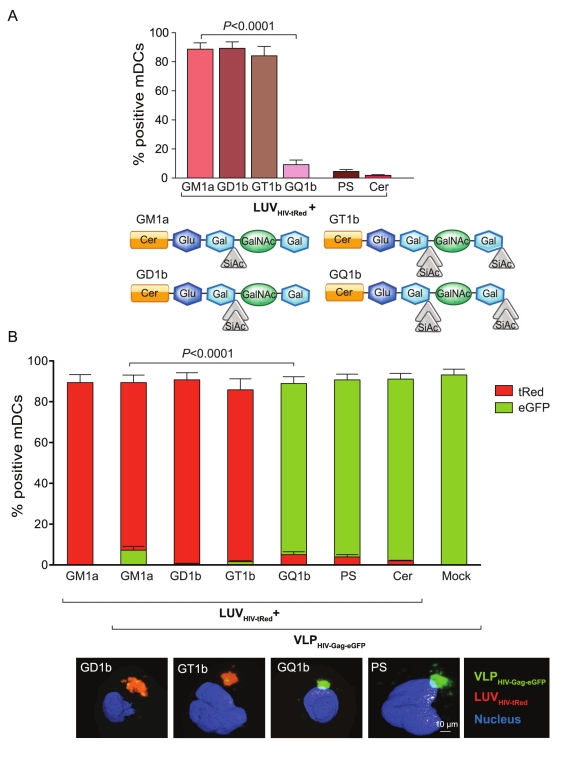
Ganglioside complexity determines mDC capture.(A) Comparative mDC capture of distinct LUVHIV-tRed containing GM1a, polysialogangliosides such as GD1b, GT1b, and GQ1b; PS and Cer. A total of 2×105 DCs were pulsed for 4 h at 37°C with 100 µM of LUVs, washed with PBS, and assessed by FACS to obtain the percentage of tRed-positive cells. Data show mean values and SEM from two independent experiments including cells from six donors. mDCs capture significantly higher amounts of GM1a-containing LUVHIV-tRed than GQ1b-containing LUVHIV-tRed (p<0.0001, paired t test). Schematic of the gangliosides in the LUVs employed for these experiments is shown underneath. (B) Capture competition between mDCs pulsed with 75 ng of VLPHIV-Gag-eGFP Gag and 100 µM of different polysialogangliosides LUVHIV-tRed. Cells were incubated for 4 h at 37°C, washed, and analyzed by FACS to determine the percentage of eGFP- and tRed-positive cells. Data show mean values and SEM from two independent experiments including cells from six donors. mDCs capture fewer VLPHIV-Gag-eGFP in the presence of GM1a-containing LUVHIV-tRed than in the presence of the same concentration of GQ1b containing LUVHIV-tRed (p<0.0001, paired t test). Representative fluorescence images from mDCs exposed to the indicated LUVHIV-tRed in these experiments are shown in the bottom of the graph. Isosurface representation of DAPI stained nucleus is shown, computing the maximum intensity of the green and red fluorescence within a 3-D volumetric x-y-z data field.